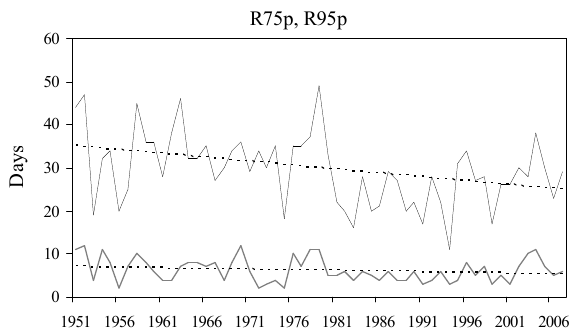
1951-2007. Dashed line indicates Sen’s estimator of the slope.